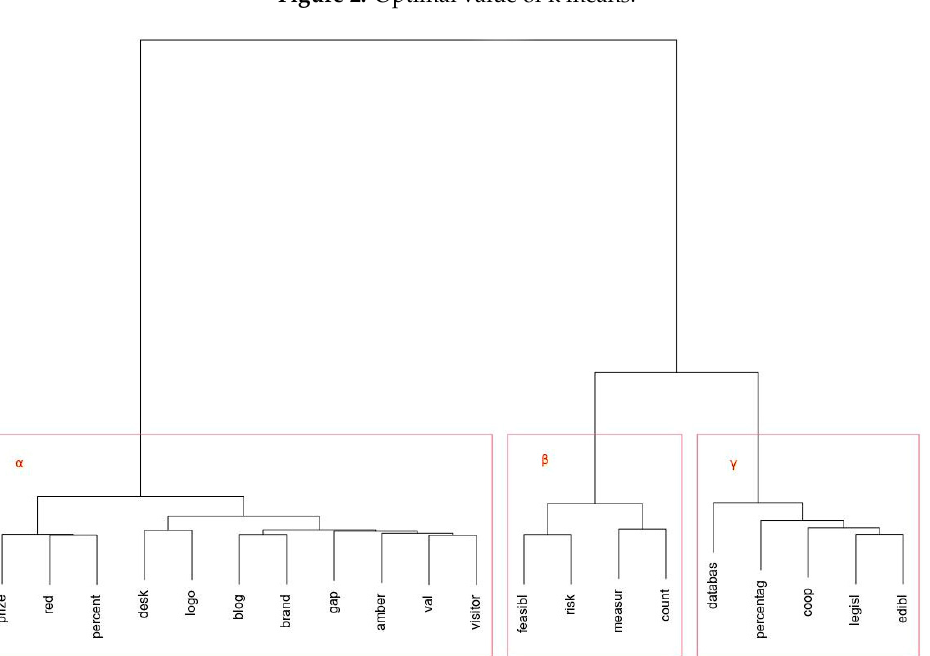
Figure 2. Optimal value of k means.